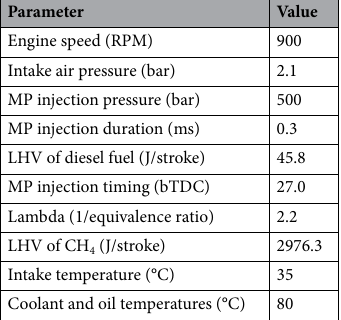
Table 2. Reference experiment conditions.